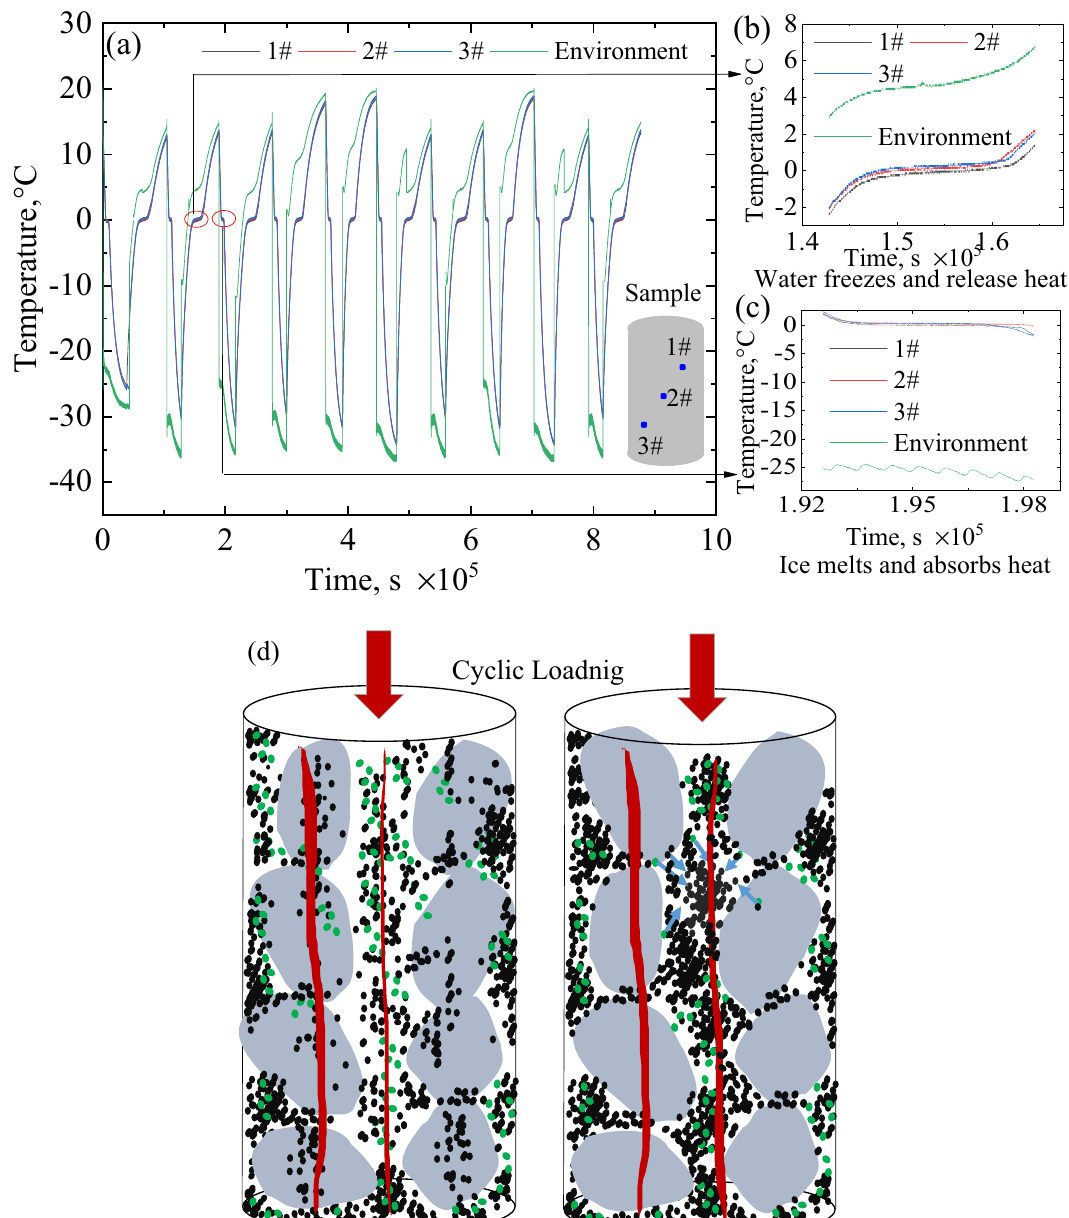
Figure 8. The process of fine matrix clusters under freezing–thawing cyclic and cyclic loading: ( a ) focusing on the temperature change during freezing–thawing, ( b ) detail diagram of Release the latent heat of the phase transition, ( c ) detail diagram of absorb the latent heat of the phase transition and ( d ) schematic diagram of fine matrix clusters filling pores before and after freezing and thawin.g Additionally, the coarse particles used in present test were unweathered granite, and there was no evident initial crack on its surface. Therefore, the coarse particles were not damaged during the freezing–thawing cycle. X-ray diffraction (XRD) test results of the fine matrix of the specimen indicated that it contained a large amount of montmorillonite, albite and minerals which possessed strong water–holding capacity, as shown in Fig. 1b. ( d ) Demonstrate the process that liquid water and fine matrix on the surface of coarse particles will be absorbed by the cluster body in the process of repeated freezing and thawing. The cluster rate increased by the migration of fine particle matrix driven by temperature load during repeated freeze–thawing process. For the fine particle matrix with strong water holding capacity, the clustering phenomenon should be more obvious during freeze–thaw process. Previous research has supported above conjecture to some extent 39,49 . The pores formed by the coarse and fine matrix skeleton were filled with the cluster body, which improved the resistance to deformation of the specimen. Furthermore, under the condition of a low content of fine matrix, liquid water was discharged from the bottom of the specimen after 10 freezing–thawing cycles. This was consistent with the work from previous work, where in the liquid water discharge undoubtedly enhanced the strength of the specimen 19 . However, the effect of the liquid water discharge on the strength of the specimen was much less evident than that of fine matrix clusters filling the pores. The dynamic loads of the specimens were borne by the coarse–particle skeleton and clusters. ( b ) Shows the schematic diagram of the force chain inside the specimen. Therefore, at present work, specimens with a higher fine matrix exhibited higher strength after freezing–thawing than those with a lower fine